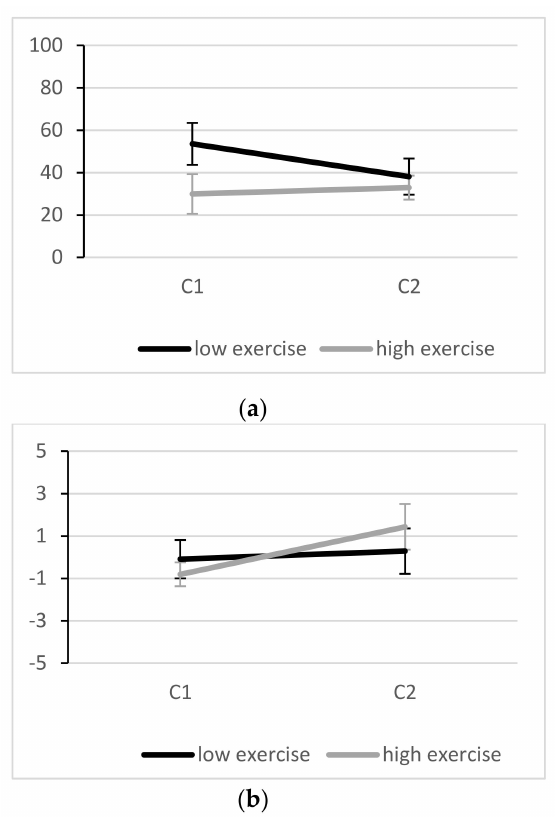
Figure 2. Stroop interference scores (incompatible minus compatible trials) for reaction time (( a ) in ms) and accuracy (( b ) in %) in the low and high exercise group. Error bars are standard errors of the